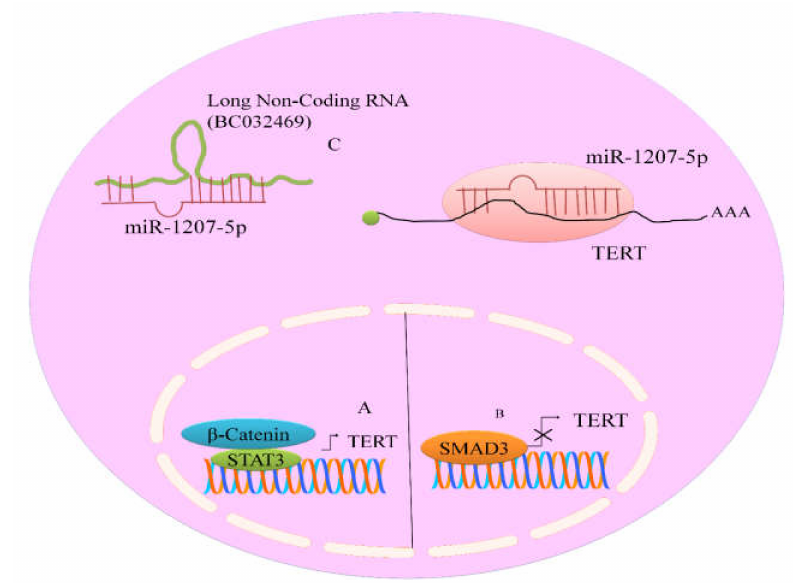
Figure 3. ( A ) Positive regulation of TERT by WNT signaling pathway specific protein ( β -catenin) and STAT3; ( B ) SMAD transcriptionally repressed TERT; ( C ) BC032469, a lncRNA contained sequences which showed complementarity to miRNA-1207-5p seed